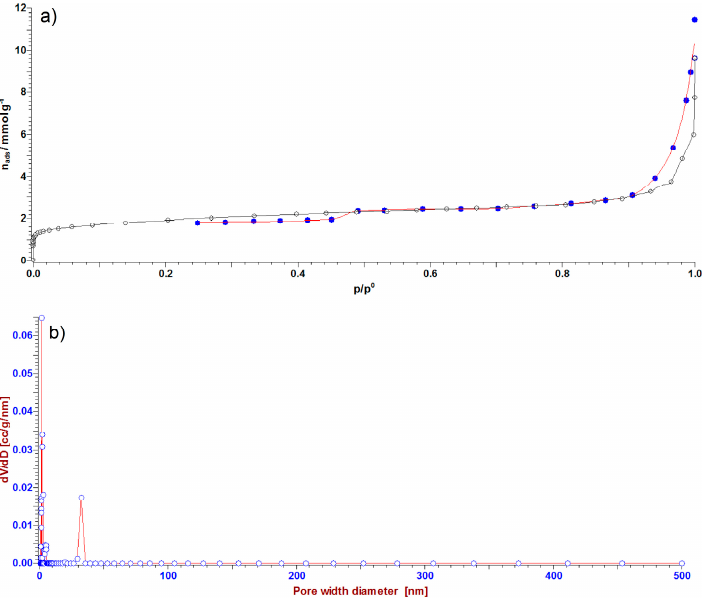
Figure 8. ( a ) Nitrogen adsorption isotherm of pure GP, given as the amount of N 2 adsorbed as the function of a relative pressure, and ( b ) corresponding pore size distribution (PSD).